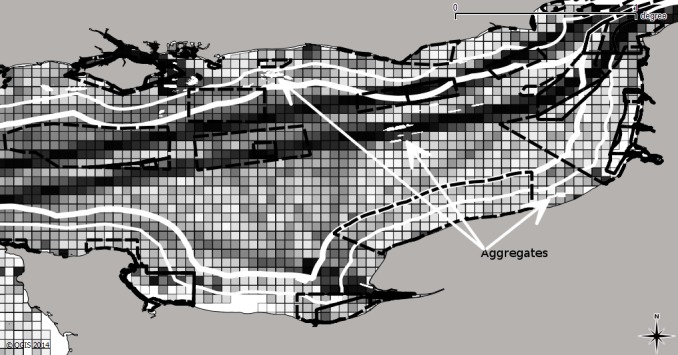
Spatial overlap of sectors (coloured pixels represent maritime traffic densities, thick and thin white lines the12 and 6 mile limits respectively, aggregate mining sites (labelled) and the dashed black line proposed Special Areas of Conservation) within the English Channel.